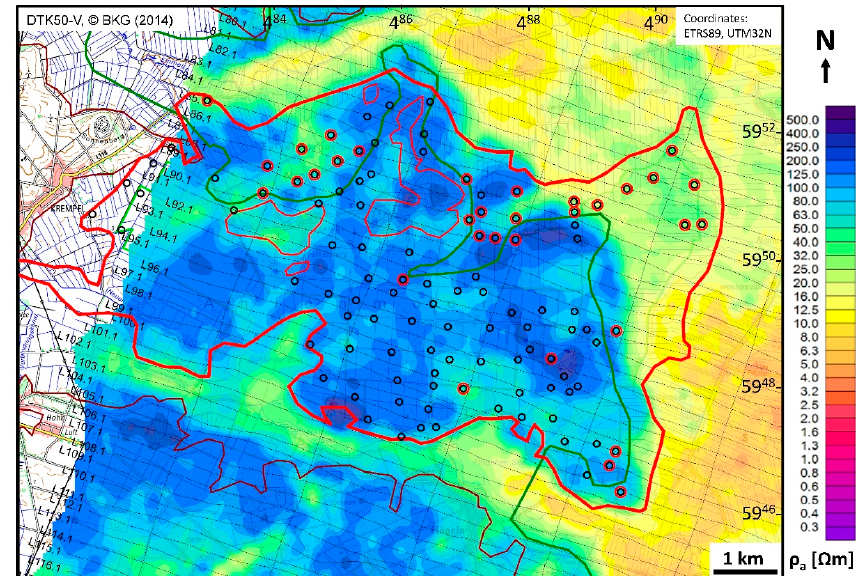
Figure 12. Apparent resistivity at the highest frequency (f = 140 kHz). Blue / orange colors indicate sandy / clayey substrate. Red circles mark boreholes with clay at the base. Red lines outline the bog, brown lines indicate the boundary of the peatland, and the green line displays the southernmost extent of marine clays [15]. The dotted lines are the numbered flight lines.